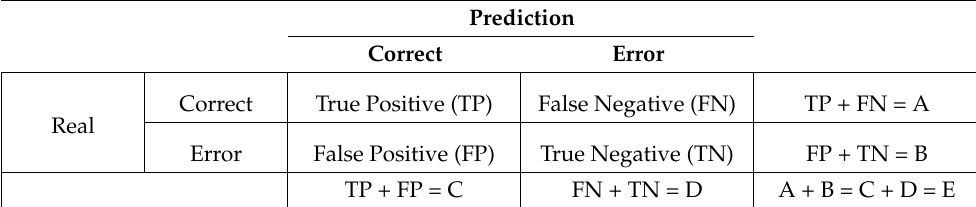
Table 1. Confusion